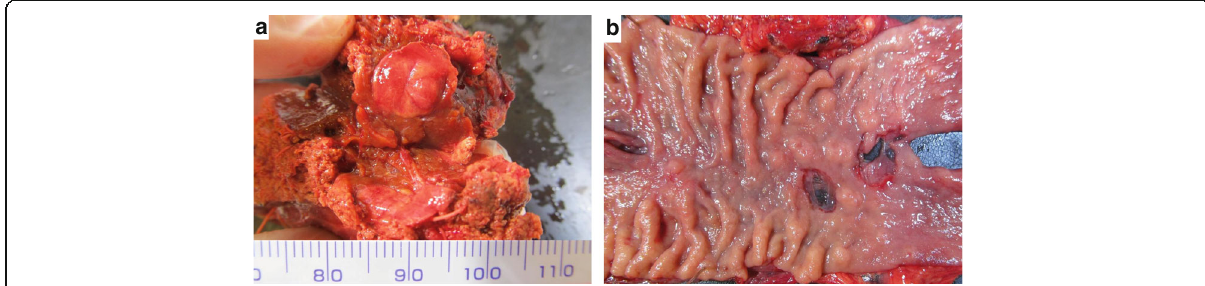
Fig. 3 Resected specimen. a A solid mass, 13 mm in diameter, was observed in the liver. b Multiple submucosal tumor-like lesions were observed in the duodenum